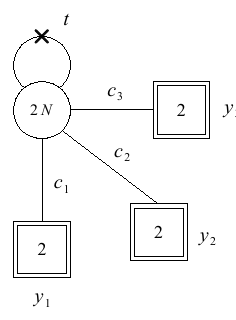
Figure 2 . Equivalent representation of the theory. This form is more suitable for the derivation of the duality we want to